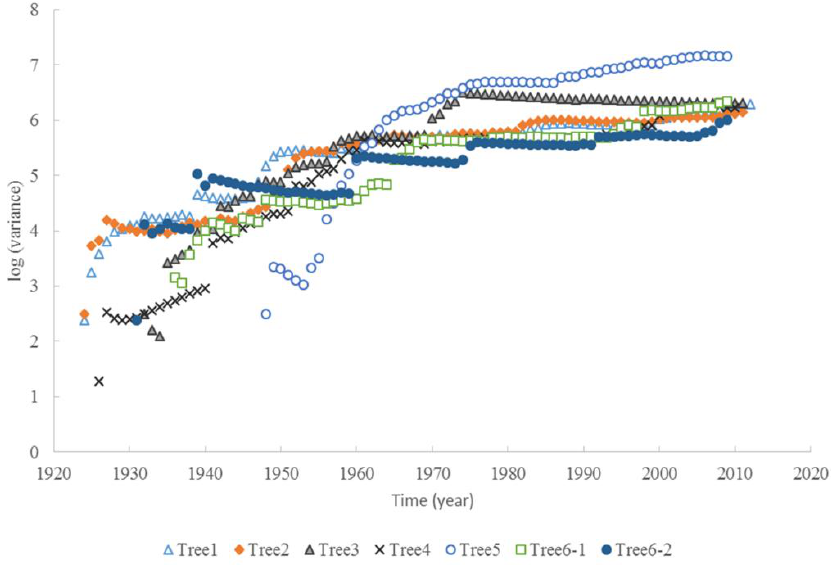
Figure 3. The variance of BAI increased with time for six Chinese Torreya trees.